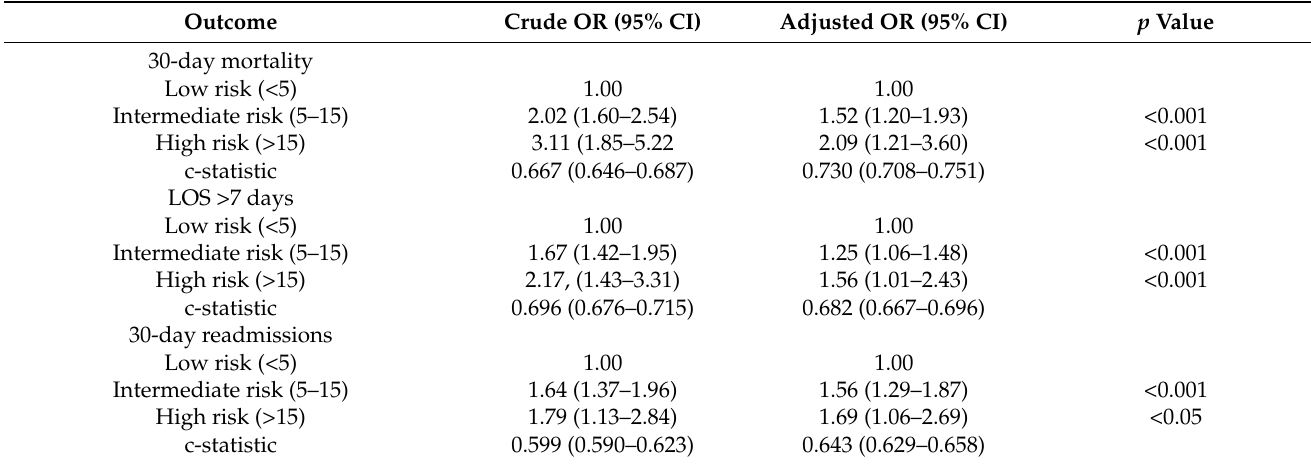
Table 3. Relationship between HFRS frailty risk and outcomes in 5182 heart-failure